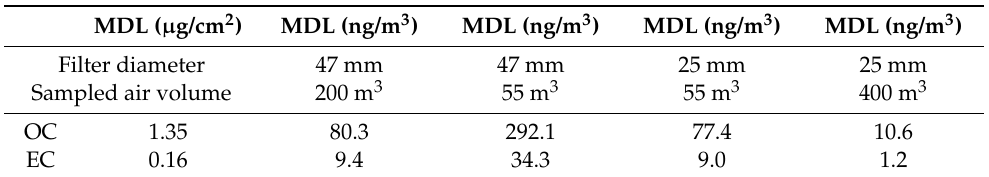
Figure 3. Organic carbon (OC) ( up ) and elemental carbon (EC) ( down ) mean blank values of the 25 filters, together with the two measurements done on each filter. Red circles and blue crosses represent the result of the measures on the two sample punches; black short lines are the average of the two measurements for every filter. Table 1. Analytical performances of the thermal-optical analyzer. Method detection limit (MDL) is expressed in µ g/cm 2 and ng/m 3 in the sampling conditions